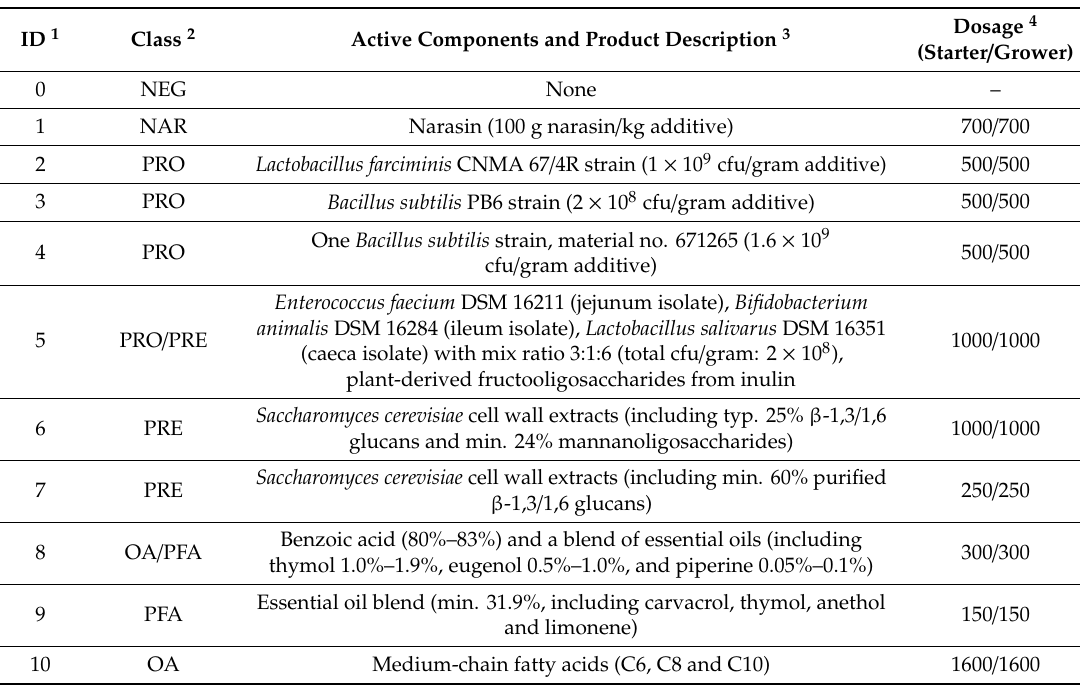
Table 2. Treatment ID, class of feed additives, active components and inclusion rate of feed additive